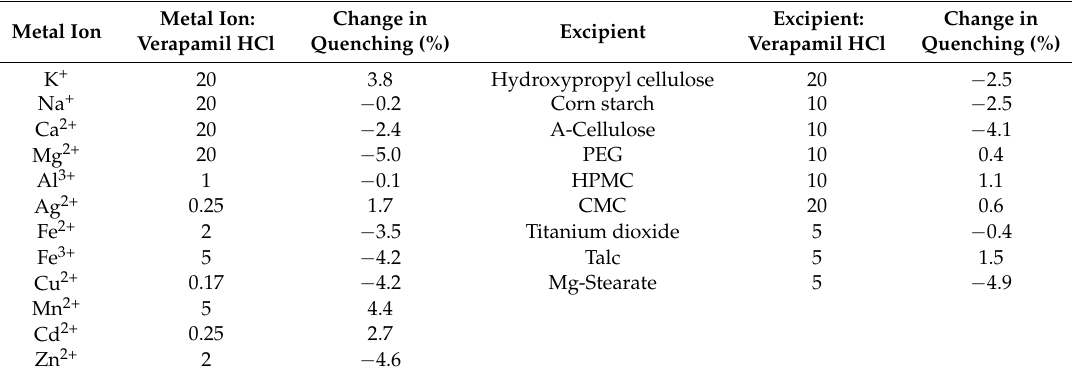
Table 2. Effect of common metal ions and excipients on fluorescence quenching.